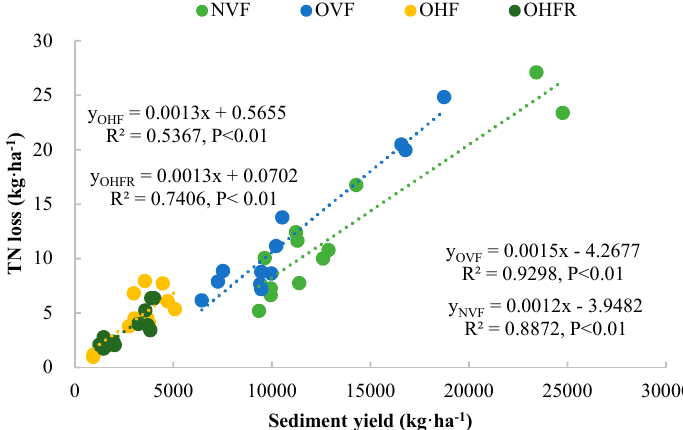
Figure 5. Linear regressions of runoff depth and rainfall under four treatments.